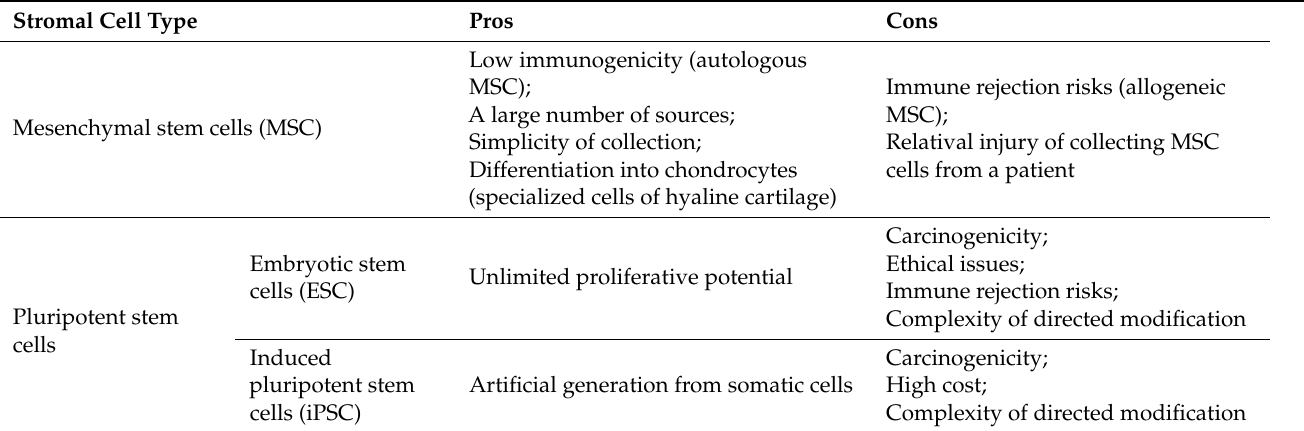
Table 1. Stem cells potency in hyaline cartilage tissue